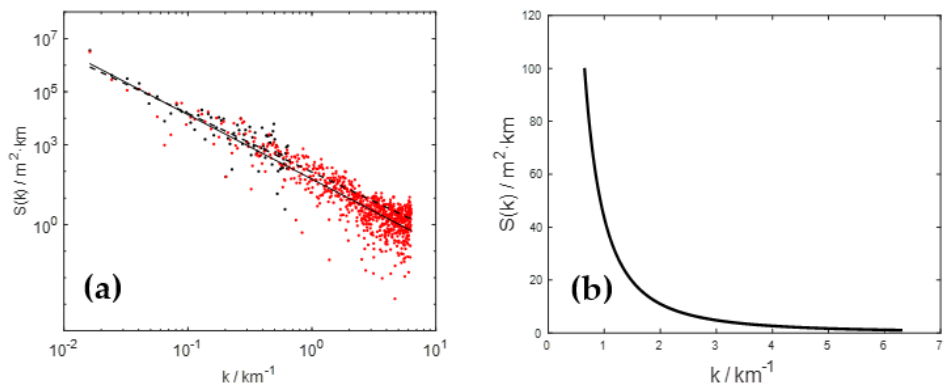
Figure 5. ( a ) The zonal terrain height variance spectra in the log–log coordinate and ( b ) the deviation of the spectral energy between 30 ″ resolution and 90 m resolution above the wavenumber of 1.59 km − 1 . The dashed line is the fitting spectral slope of 30 ″ resolution based on the black dots and the solid line represents the slope of 90 m resolution based on the red dots.